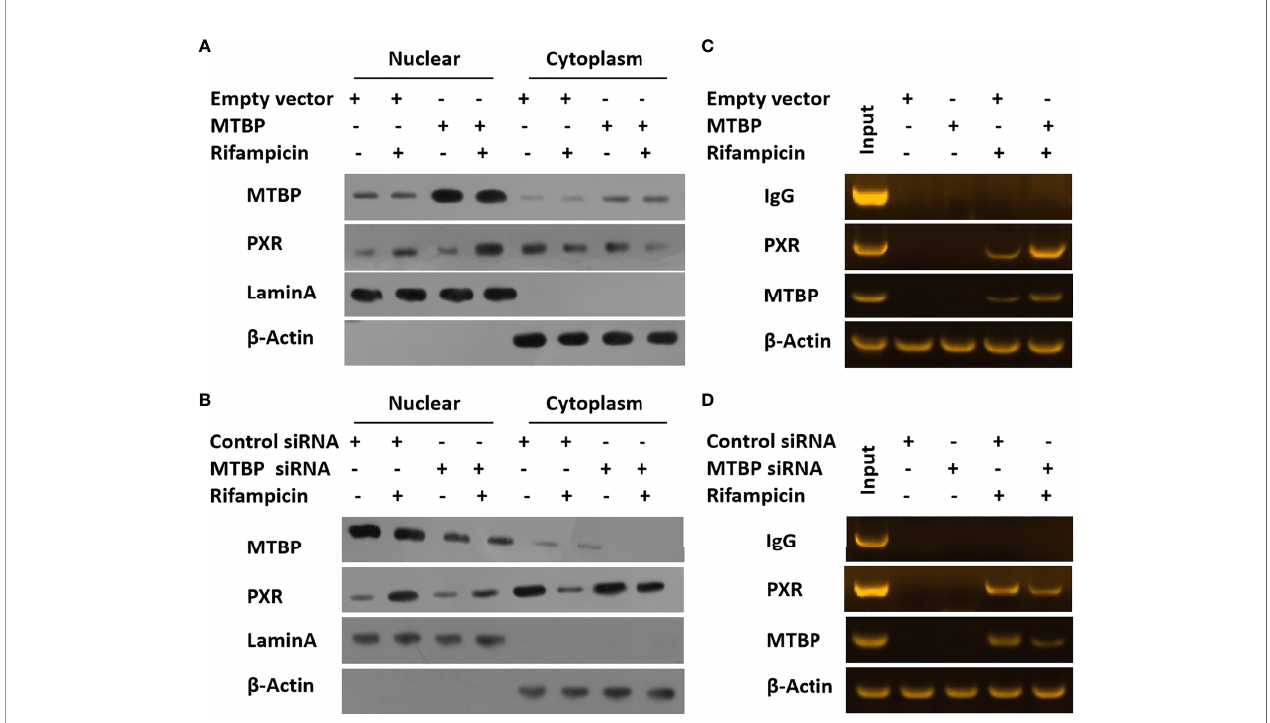
FIGURE 4 | MTBP promotes the accumulation of PXR in nuclear or the recruitment of PXR to the promoter regions of its downstream gene. The MHCC97-L (A) cells were transfected with an empty vector or MTBP, whereas the MHCC97-H (B) cells were transfected with a control siRNA or the siRNA of MTBP. Cells were treated with a solvent control or rifampicin and harvested for the cellular sub-fraction experiments. The expression levels of PXR or MTBP in cellular sub-fractions was examined by the western blot assay. The Lamin A (the nuclear-skeletal protein) was used as the indicator of the nuclear sub- fraction, whereas b -Actin was used as the indicator of the cytoplasm sub-fraction. The MHCC97-L (C) cells were transfected with an empty vector or MTBP, whereas the MHCC97-H (D) cells were transfected with a control siRNA or the siRNA of MTBP. Cells were treated with a solvent control or rifampicin and harvested for the ChIP